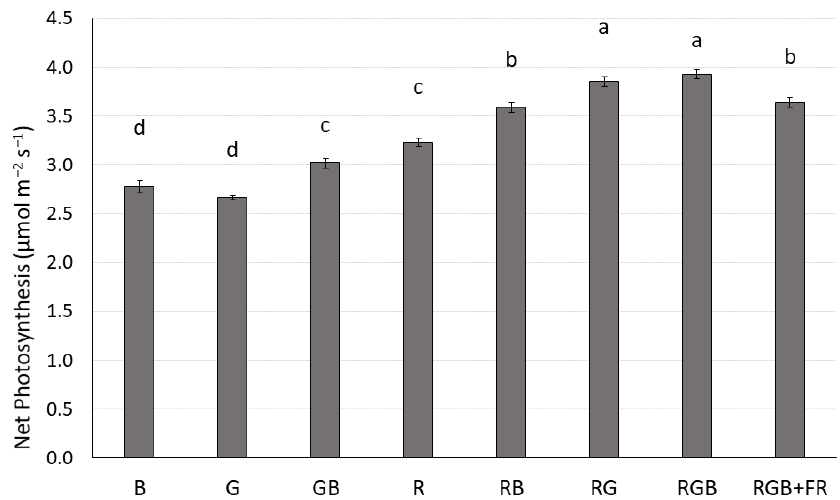
Figure 2. Net photosynthesis (A) under ambient treatment lighting. Different lowercase letters indicate significant differences ( p ≤ 0.05; n = 6). Error bars are the standard error. Uppercase letters indicate light treatments.